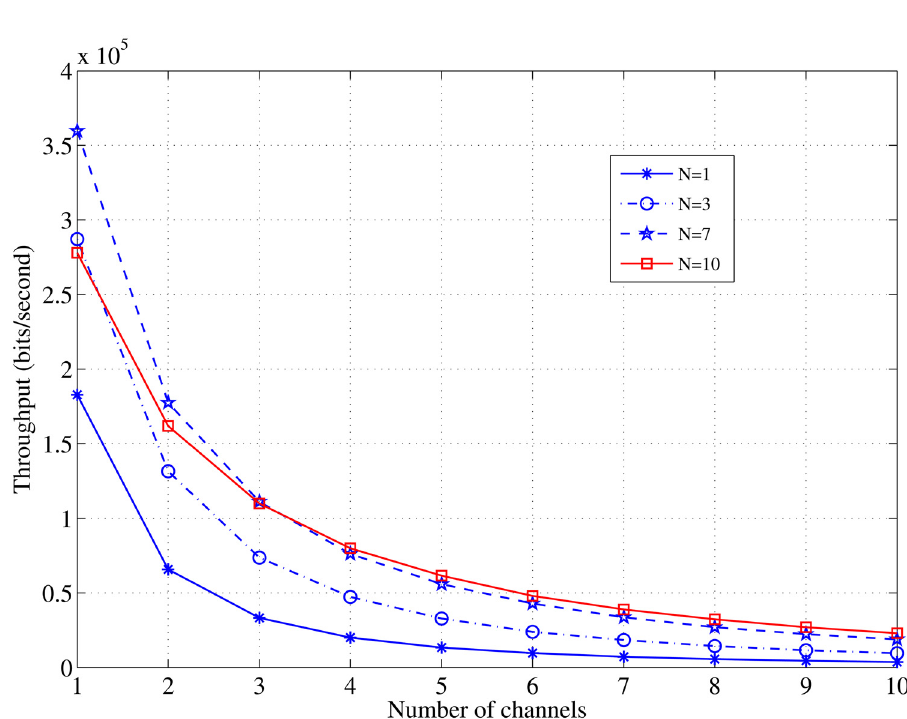
Fig 9. Relationship between C and the throughput in case of various values of N ; τ off = 0.5, L = 1000